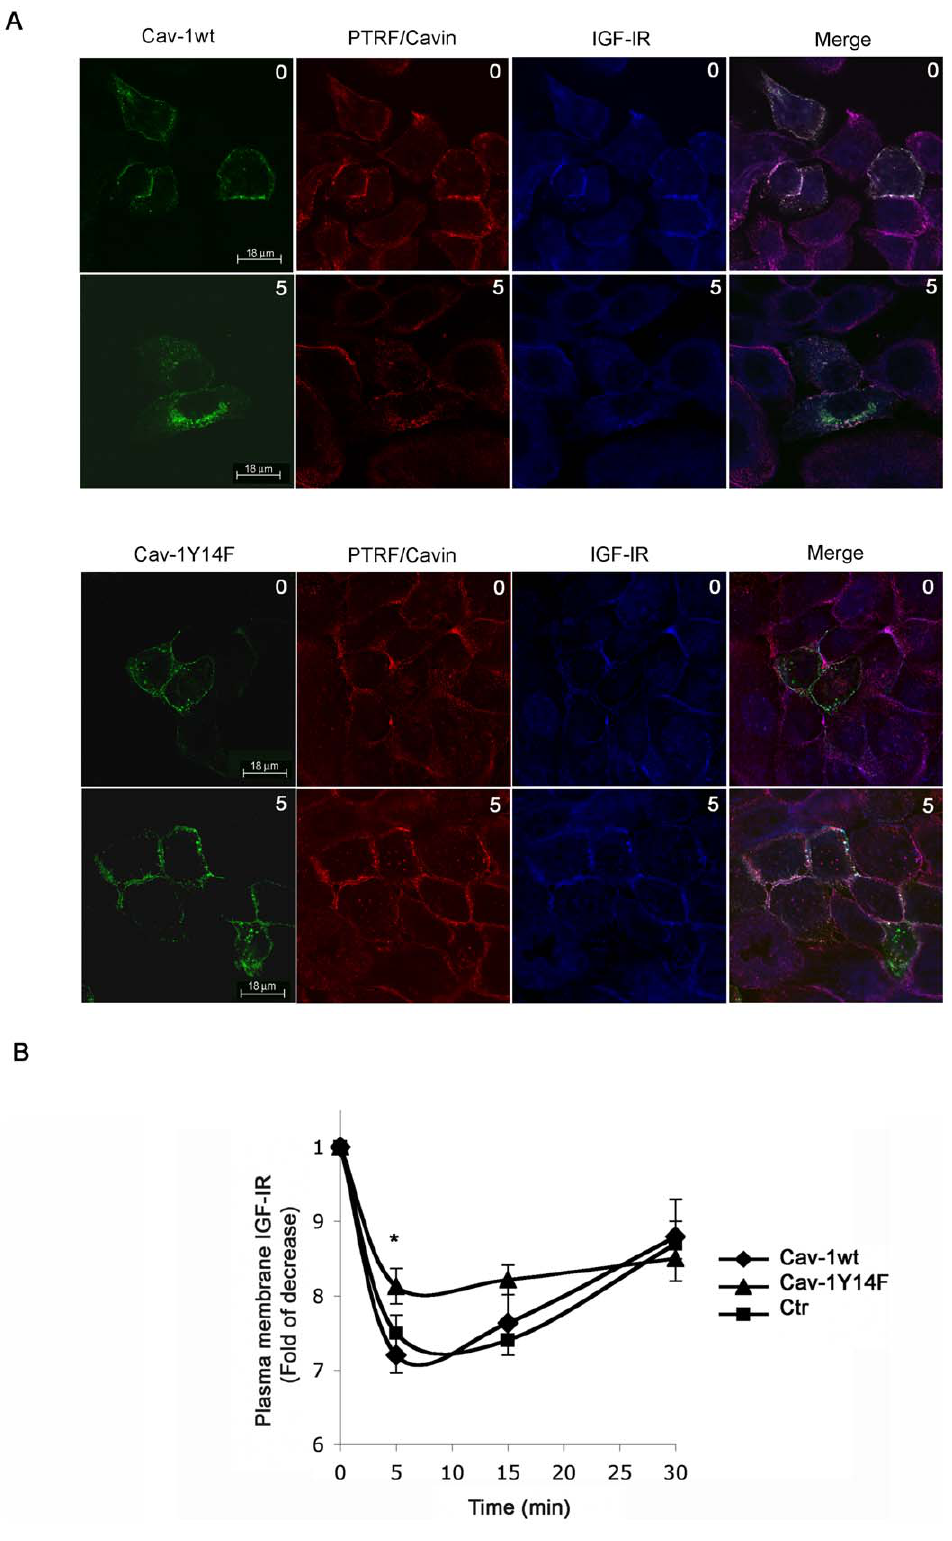
Figure 5. Expression of CavY14F mutant decreases IGF-IR internalization in IGF1 stimulated cells. (A) Hacat cells were transiently transfected with pEGFPN1 Cav-1-wt and pEGFN1 Cav-1Y14F plasmids. 48 hours after transfection serum starved HaCat cells were stimulated with IGF1 10 nM for 5 min, fixed in 4% formaldehyde, permeabilized with Methanol at 2 20 u C, labeled with a rabbit anti-PTRF/Cavin (red) and a mouse anti-IGF-IR (blue) imaged by confocal immunofluorescence microscopy. Merged fields show co-localization (white) of Cav-1wt, PTRF/Cavin, IGF-IR (upper pannels) and Cav-1Y14F, PTRF/Cavin and IGF-IR (bottom panels). (B) 48 hours from the transfection, serum-starved cells were treated with IGF110 nM for the indicated times, trypsined, washed, blocked and incubated with a mouse PE-conjugated IGF-IR.antibody. PE-conjugated IGF-IR